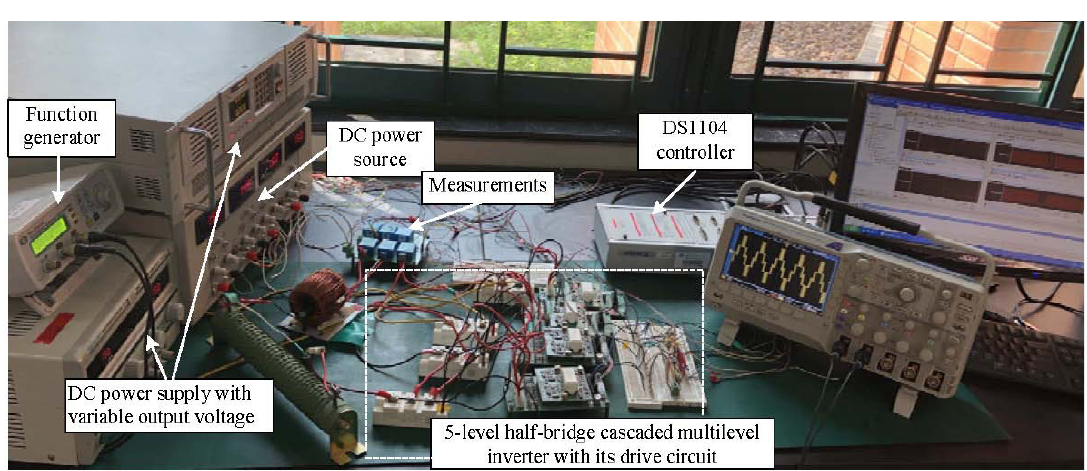
Figure 4. The hardware and interface of the experimental